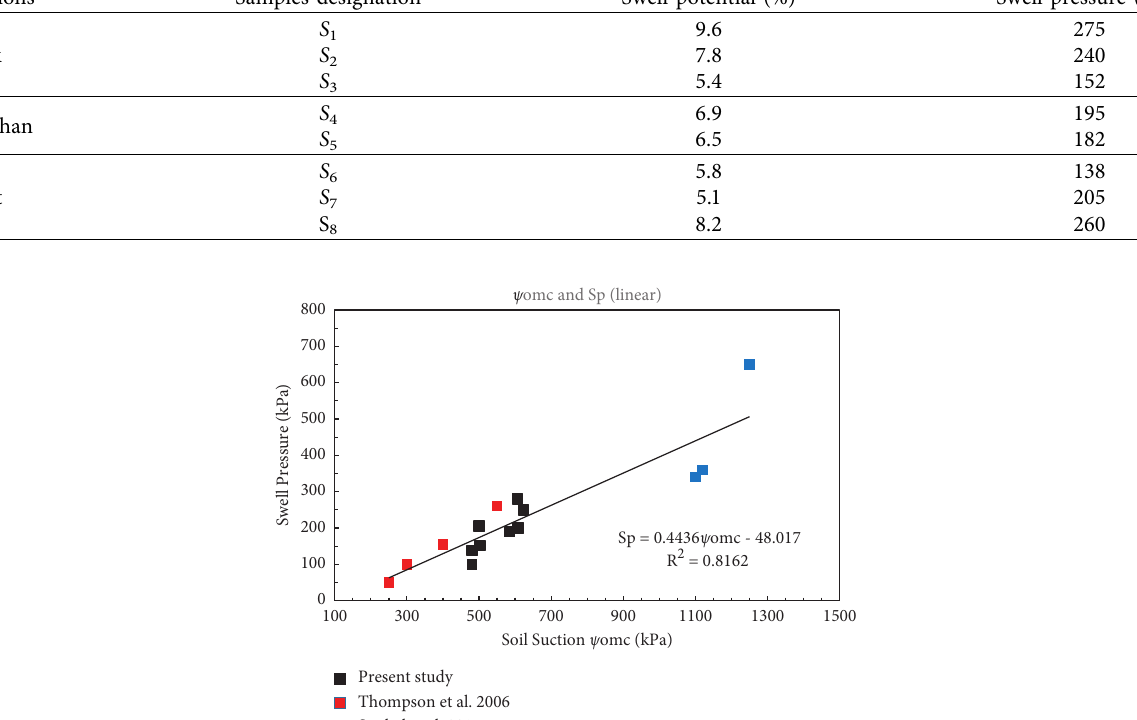
Figure 4: Fabrication of specimen for swell pressure and oedometer used in this study. Table 3: Summary of swell potential ( S ) and swell pressure ( S Locations